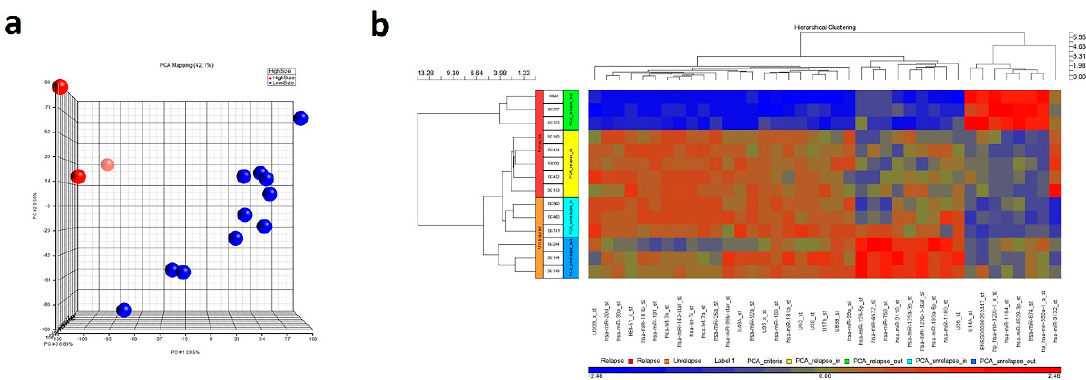
Figure 1. ( a ) Principal component analysis of the 14 samples included in the discovery series. Whole expression of the miRNAs included in the microarray showed a good discriminant power clustering the samples according to its prognosis. ( b ) Clustering and HeatMap considering de-regulated genes in the microarray.